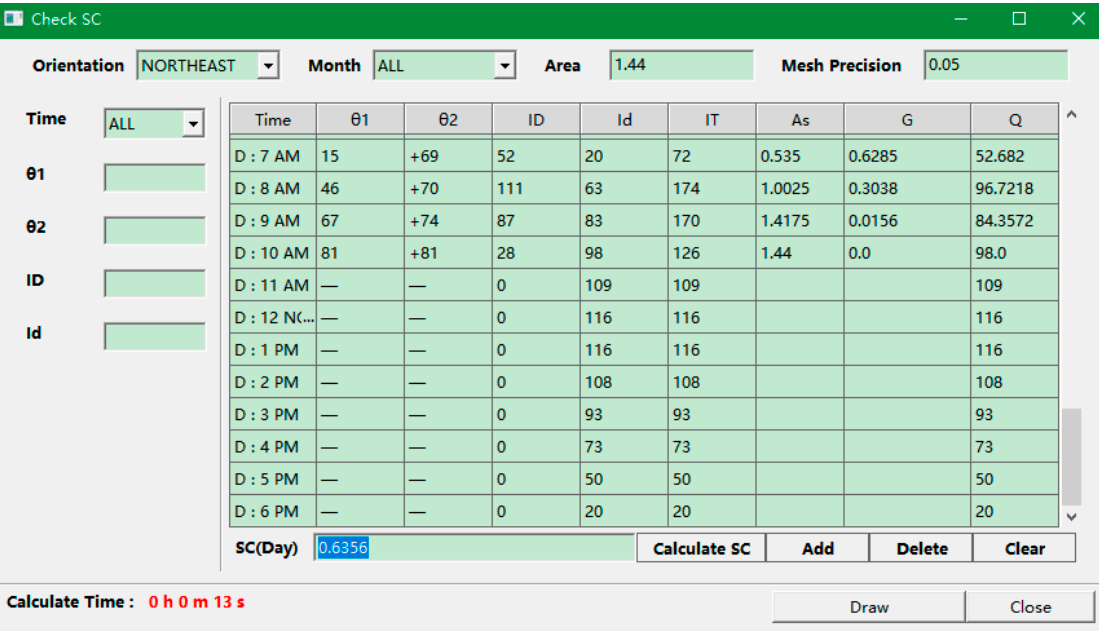
Figure 15. Shading plate with a longer length.